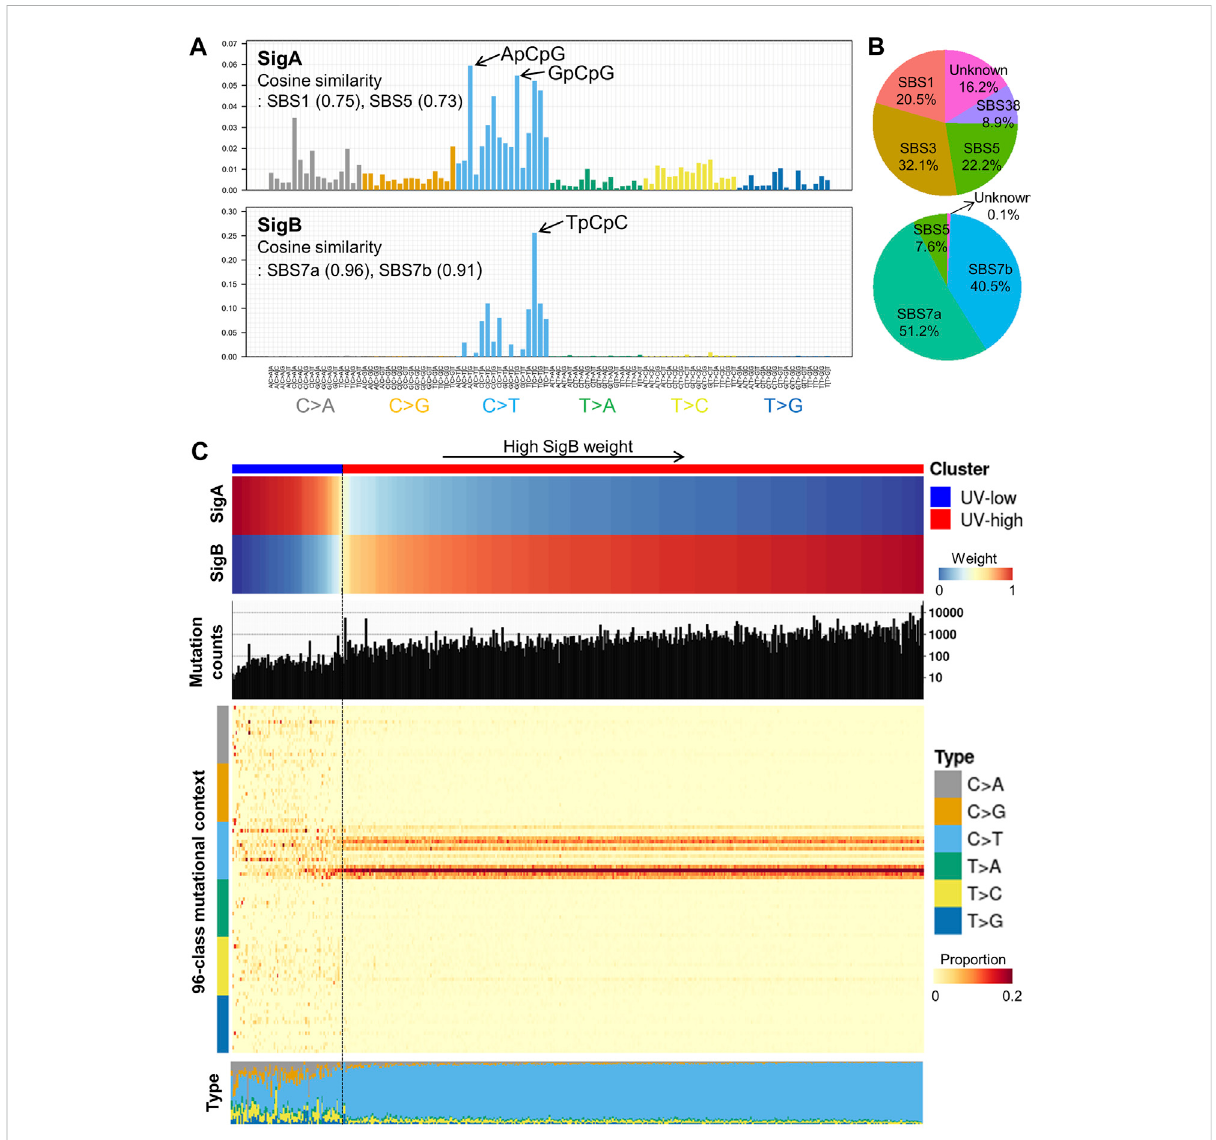
FIGURE 1 De novo mutational signature extraction and unsupervised clustering in TCGA CM dataset. (A) De novo mutational signature extraction using NMF identi fi ed two mutational signatures: “ SigA ” and “ SigB. ” The upper and lower bar plots represent the mutational context of SigA and SigB, respectively. (B) Pie charts represent signature re fi tting analysis of SigA and SigB signatures. (C) Weight of SigA and SigB, mutational counts, and mutational contexts of TCGA dataset are shown for each sample ( X -axis). Unsupervised k-means clustering of melanoma samples yielded two clusters: UV-low ( N = 75) and UV-high ( N = 391). Samples (column) are arranged by the weight of SigB, and column bar indicates